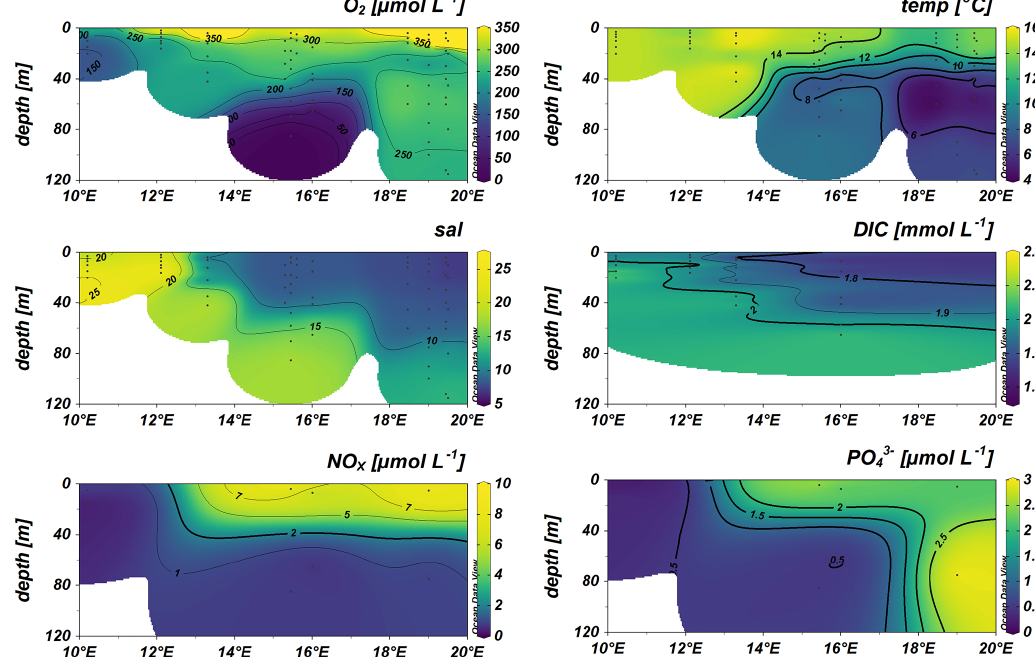
Figure 2. Distribution of surface water O 2 (µmolL − 1 ), temperature (temp) ( ◦ C), salinity (sal), dissolved inorganic carbon (DIC) (mmolL − 1 ),